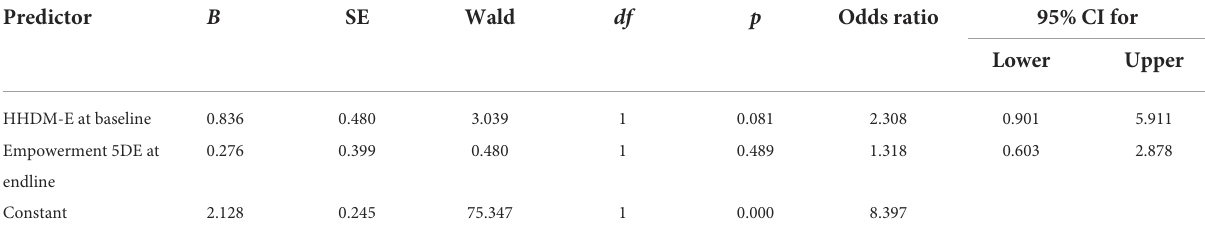
TABLE 7 Logistic regression results for egg consumption based on HHDM-E at endline. Logistic regression predicting likelihood of egg consumption based on HHDM-E at endline Predictor B SE Wald df p Odds ratio 95% CI for Lower